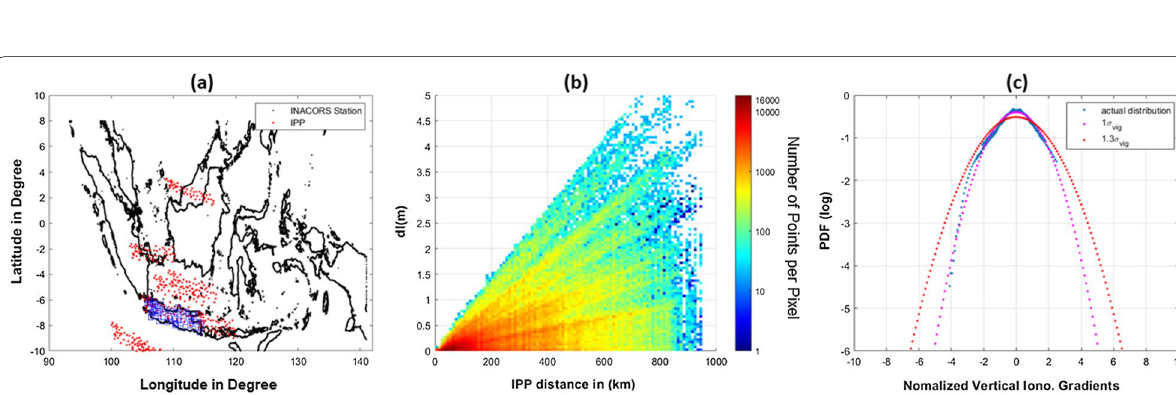
values in Sumatra and vig